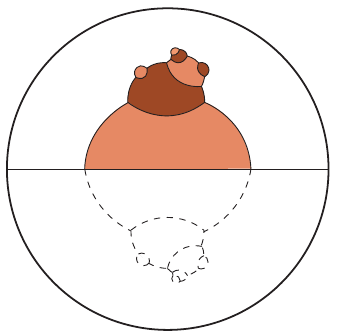
Figure 6.11 . Generating curve for a possible nonstandard area-minimizing double bubble in H n